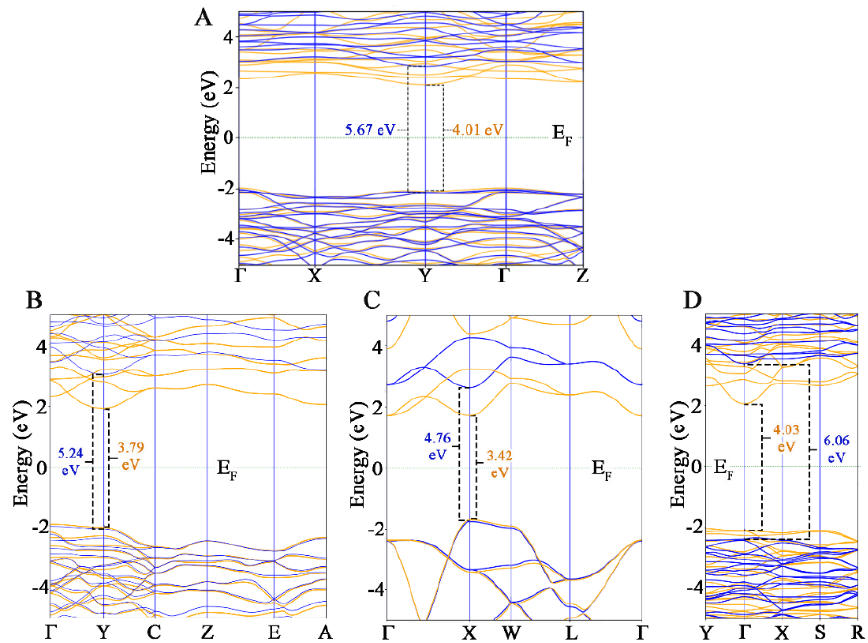
Figure 3. Calculated electronic band structures of o- ( A ), m- ( B ), c- ( C ), and t- ( D ) HfO 2 polymorphs using GGA (orange) and GGA + U (blue) approach. Fermi level is highlighted by a dotted line. After the calibration, the PBE-GGA + U approach has been used to identify differences in the bandgap values, that have been obtained from partial and total DOS compar- tures in the valence band have been evidenced. In the m-HfO 2 the calculated bandgap value was 5.246 eV. In the o-HfO 2 a similar trend with respect to the previous phase has been observed, also considering the Hf and O contributions. The calculated bandgap was 5.627 eV, and a different trend has been detected for the c-HfO 2 ; two parts in the conduction band have been found, the first from 2.783 to 4.189 eV, the second starting from 5.538 eV. The resulted band gap value was 4.753 eV. A similar trend in Hf and O contributions has been observed for t-HfO 2 , but very different values in bandgap have been detected. The lower part of the conduction band was between 2.827 eV to 4.216 eV, while the upper one started from 5.462 eV, with a resulting bandgap of 6.046 eV.